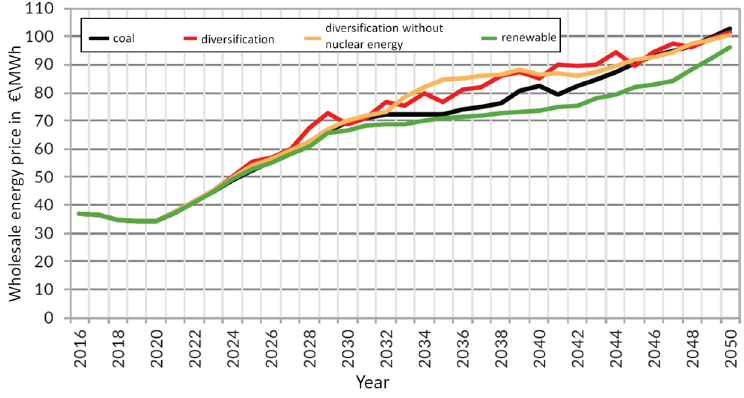
Figure 5. Energy price forecast to 2050 [28].